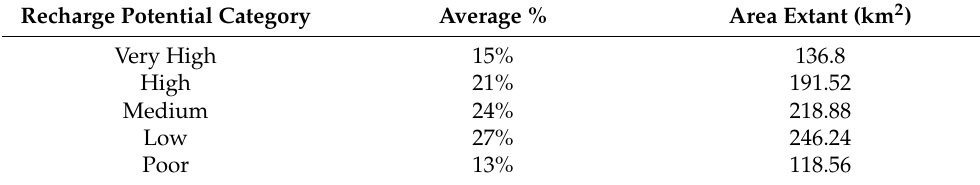
Table 6. Classification of potential recharge